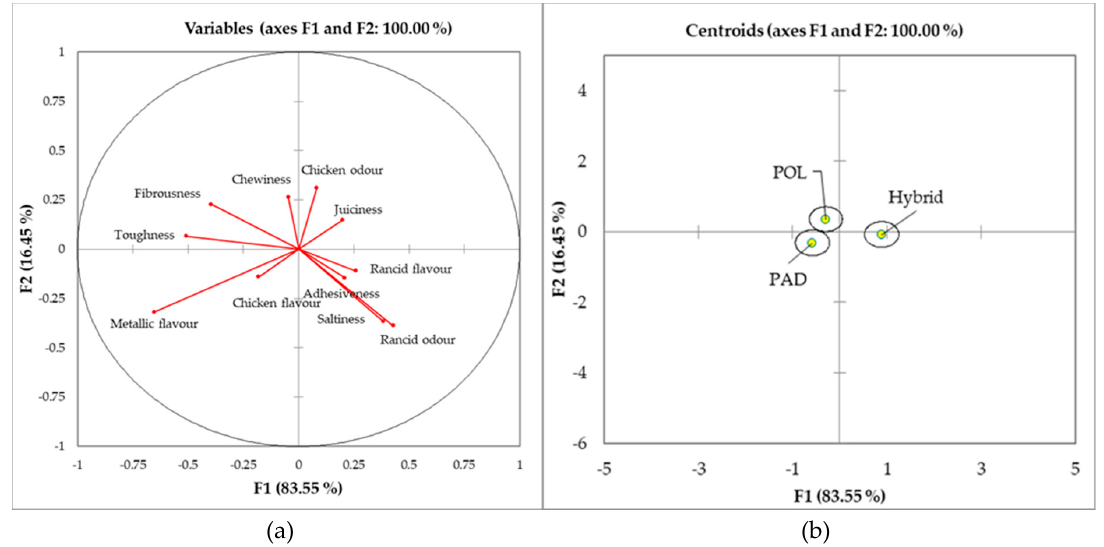
Figure 1. ( a , b ) Discriminant analysis performed on the sensory data of the trained panel. Hybrid: Hybrid chicken. PAD: Padovana slow-growing breed. POL: Polverara slow-growing breed.